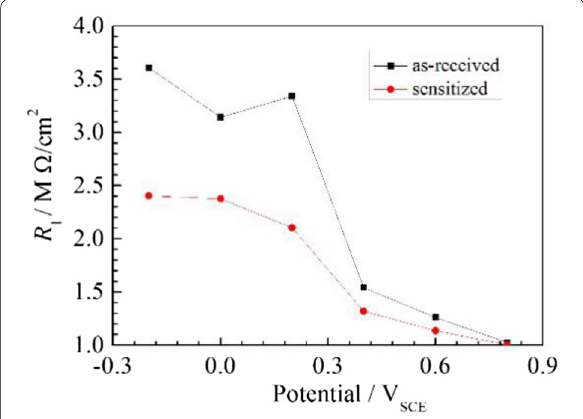
Figure 5 A comparison of the variation potential of the charge-transfer resistance between as-received and sensitized